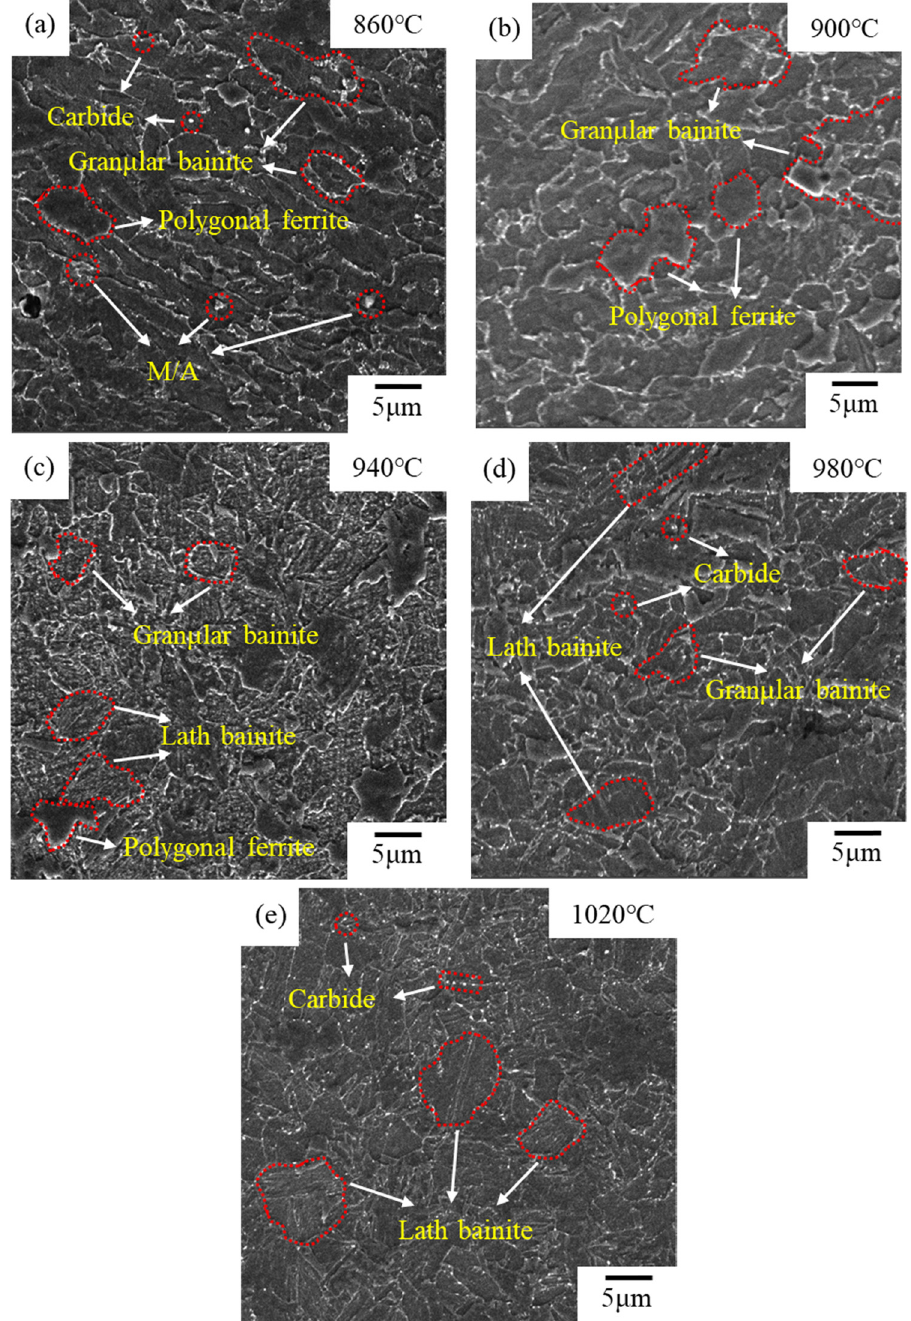
Figure 6: The SEM morphology of experimental steel at di ff erent quenching temperatures: ( a ) 860°C; ( b ) 900°C; ( c ) 940°C; ( d ) 980°C; and ( e )